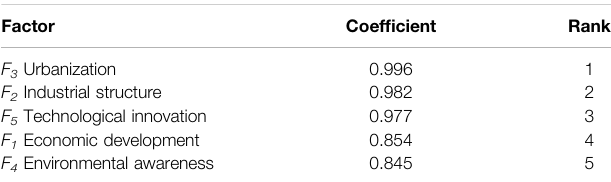
TABLE 4 | Correlation coef fi cients of in fl uencing